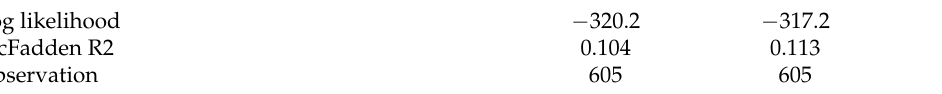
Table A2 shows the effects of relay migration with different comparison